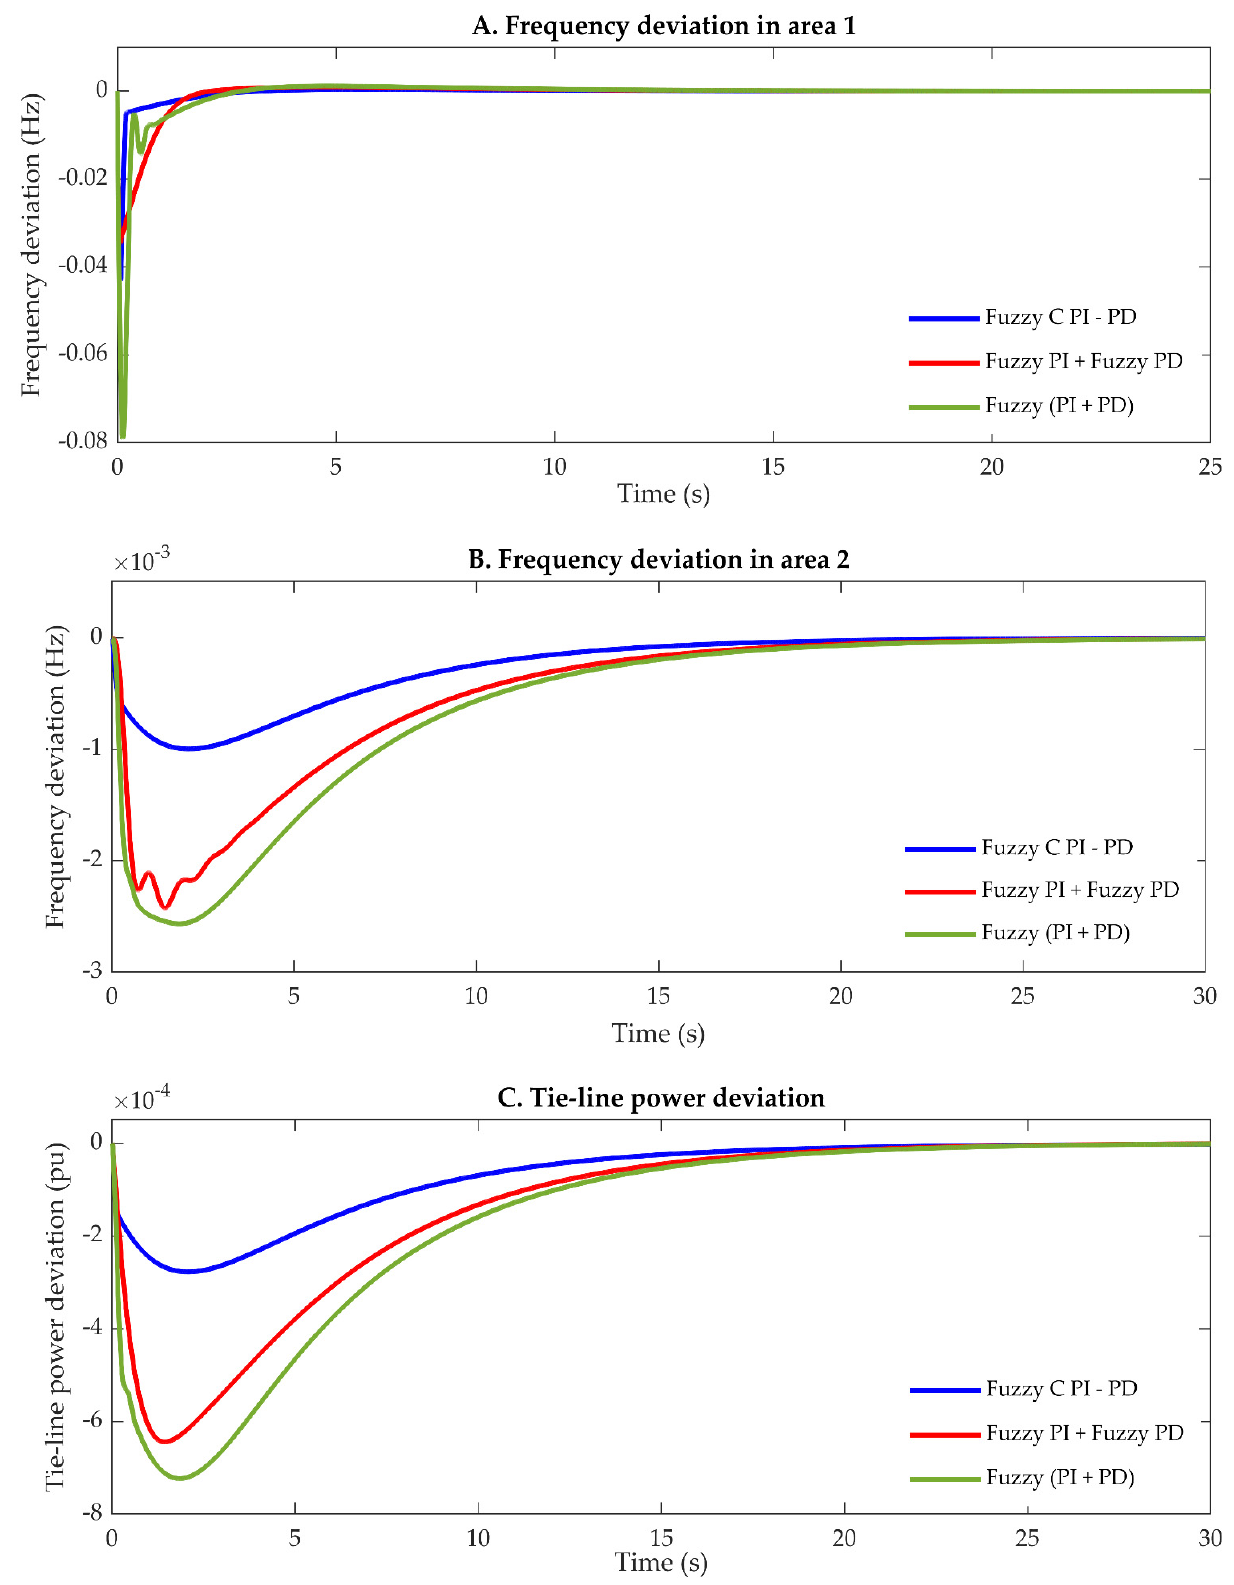
Figure 28. Dynamic response of the testbed power system based on different fuzzy controllers under parametric uncertainty conditions, case 7. ( A ) Frequency variation in area 1; ( B ) frequency variation in area 2; ( C ) tie-line power variation.